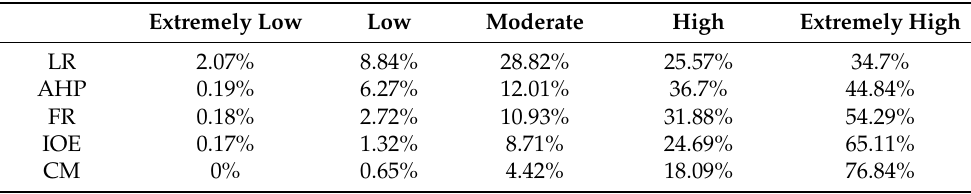
Table 7. Percentages of susceptibility classes according to the method used.